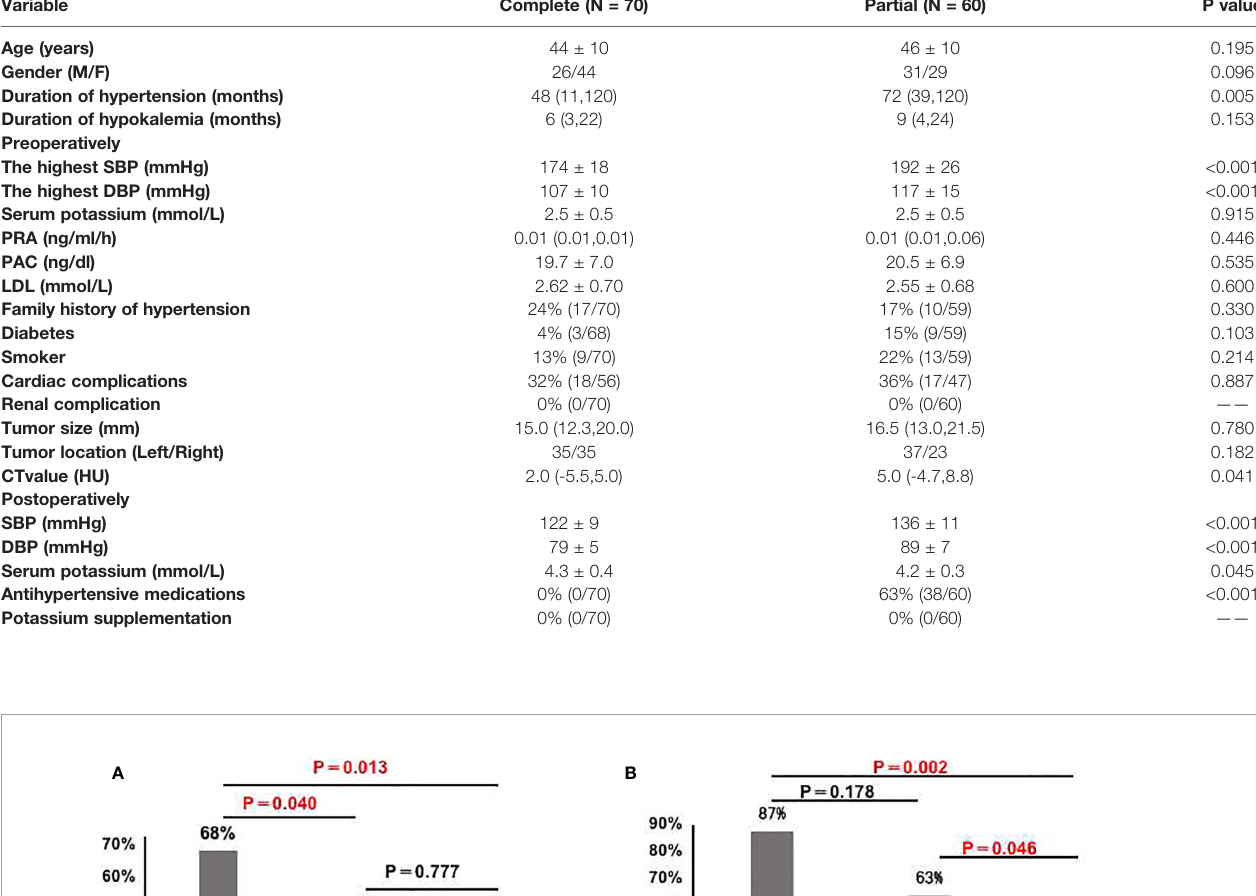
TABLE 2 | Comparison of clinical characteristics between 130 patients with classical histopathologic fi ndings with complete and partial clinical success.